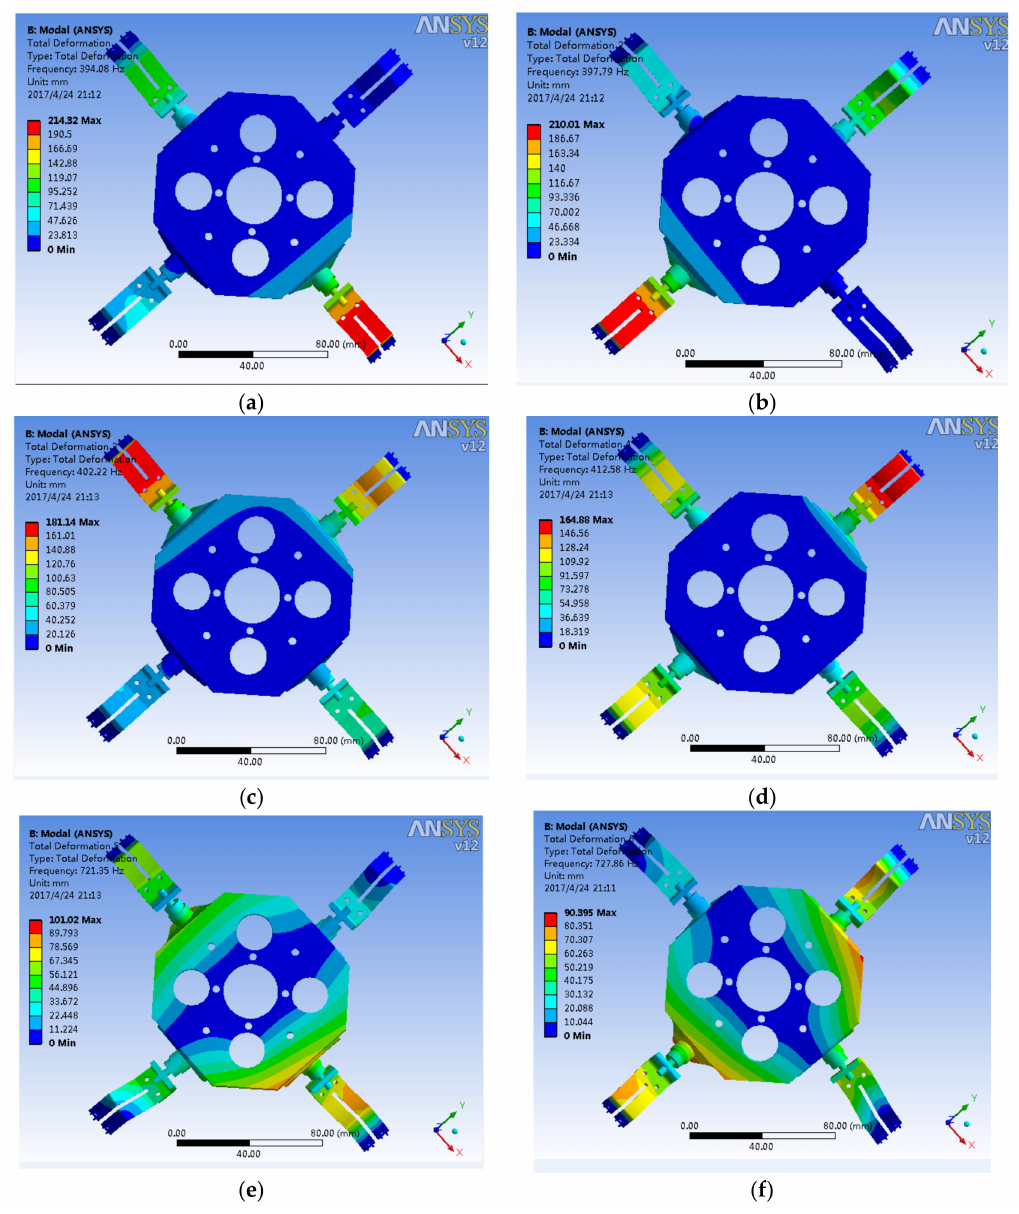
Figure 11. Displacements under vibration modes of the first six orders. ( a ) Vibration mode of the first order; ( b ) Vibration mode of the second order; ( c ) Vibration mode of the third order; ( d ) Vibration mode of the fourth order; ( e ) Vibration mode of the fifth order; ( f ) Vibration mode of the sixth